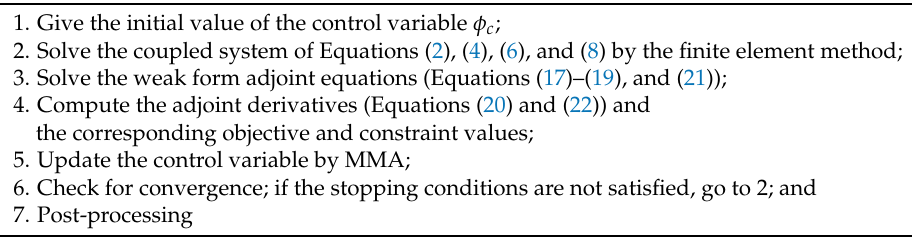
Table 1. Procedure of the iterative approach for solving the optimal control problem.